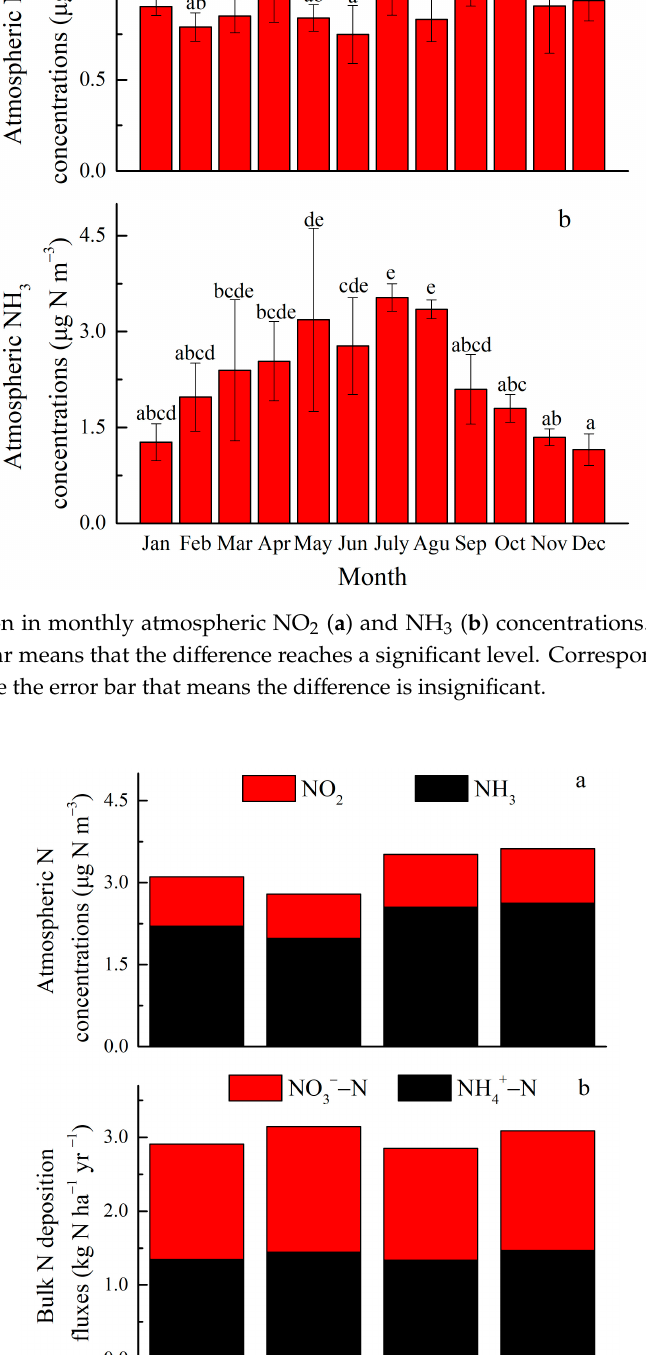
Figure 5. Annual trends in atmospheric Nr concentrations ( a ) and bulk Nr deposition ( b ).